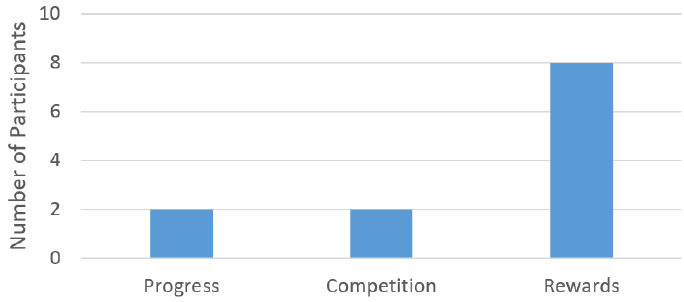
Figure 13. Version chosen during task T6.